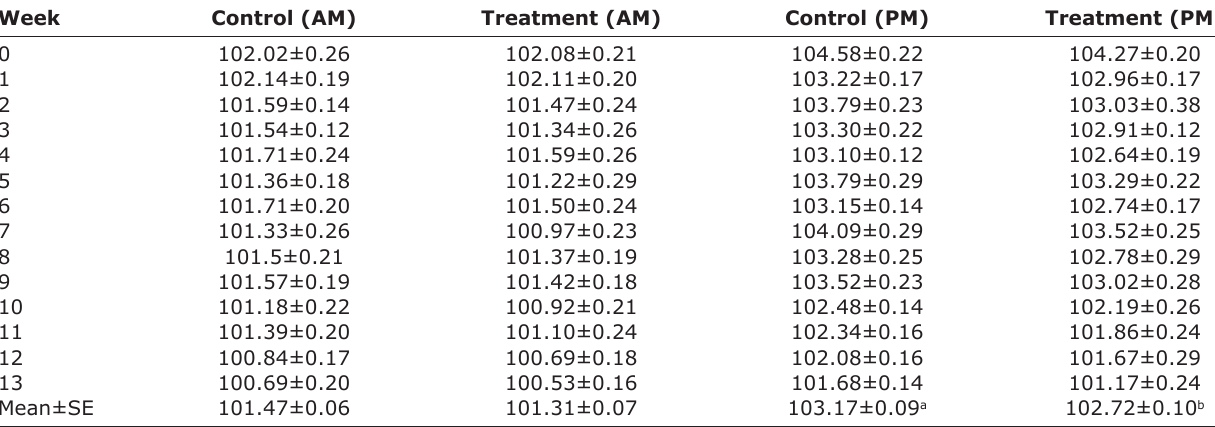
Table-3: Weekly morning (AM) and afternoon (PM) rectal temperature (°F) in KF heifers. Week